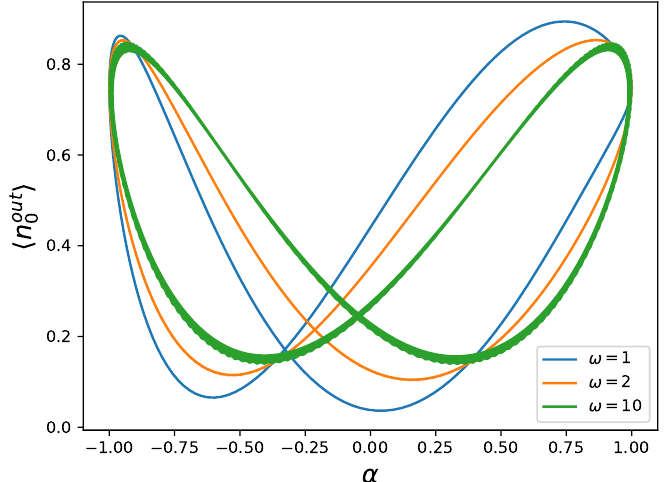
(cid:105) of the outgoing beam versus α = cos ω t for Figure 7. Number of photons (cid:104) n out 0 a frequency-superposition Fock state, displaying a pinched hysteresis loop, where the point of crossing approaches zero with higher ω . This system does not behave as a memristor. We have plotted this for three different frequencies, namely ω = 1 (blue), ω = 2 (orange), and ω = 10 (green), exemplifying that the area of the loop does not seem to decrease for higher frequencies. We have used φ ( 0 ) = π , and 2 ω 0 = 1 (see Appendix A for directions of the hysteresis